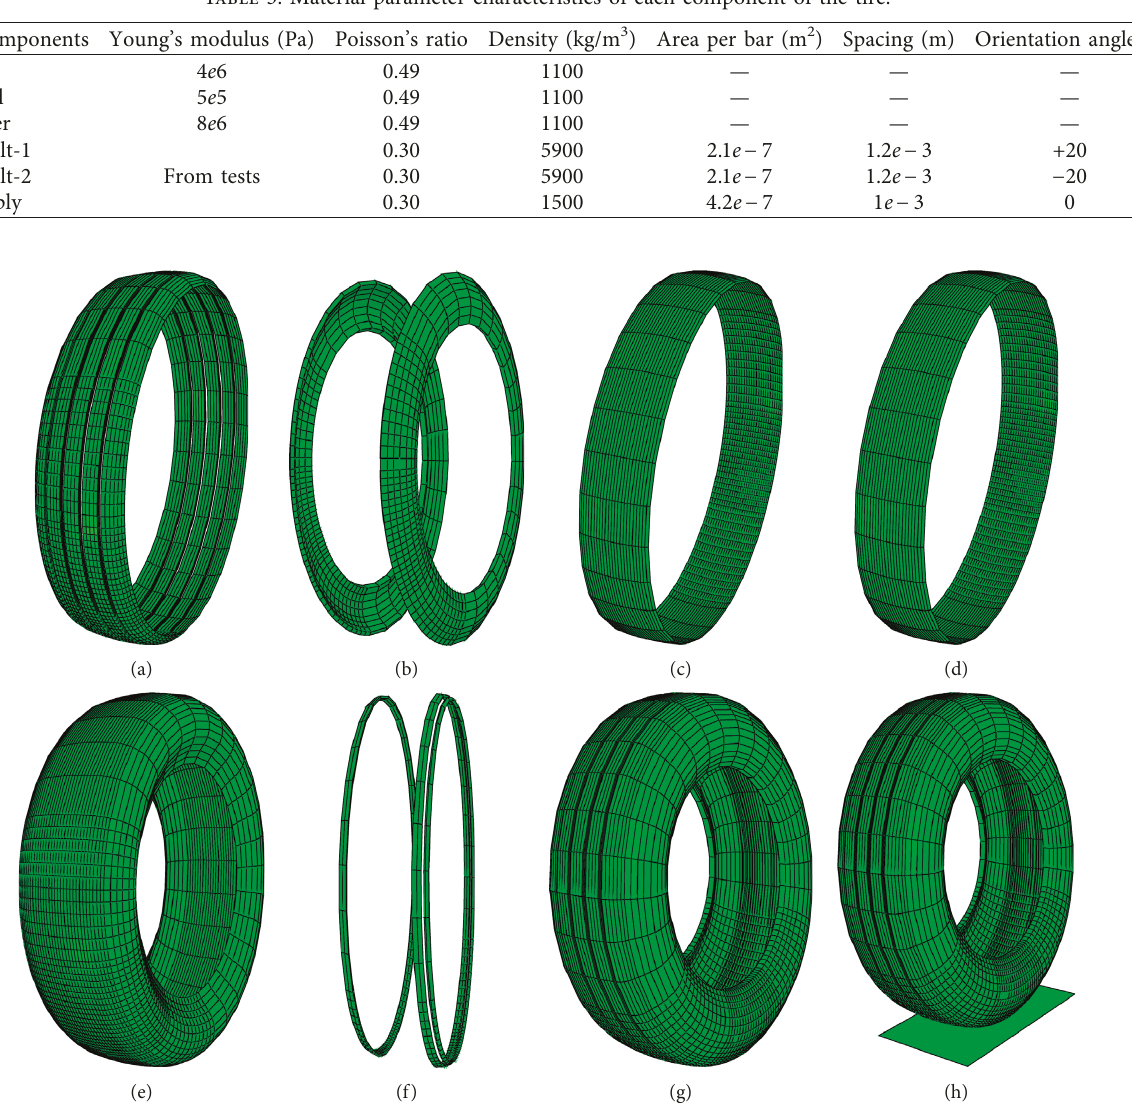
Figure 1: Meshes of bus tire components. (a) Tread. (b) Sidewall. (c) Steel-belt-1. (d) Steel-belt-2. (e) Radial ply. (f) Shoulder. (g) Full tire. (h) The tire-pavement